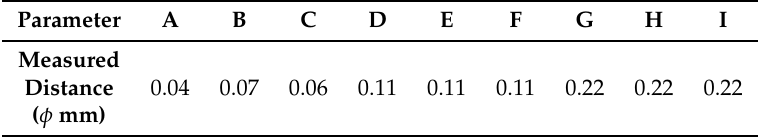
Figure 12. Wheel arch pressure tappings. Table 1. Wheel arch pressure tappings: internal surface measured distances (half).